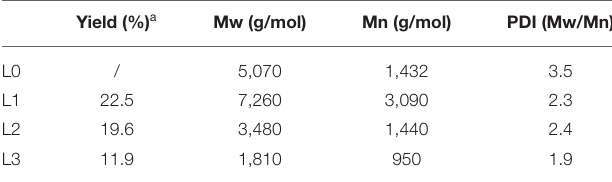
TABLE 1 | The fractionation yields and molecular weight of lignin